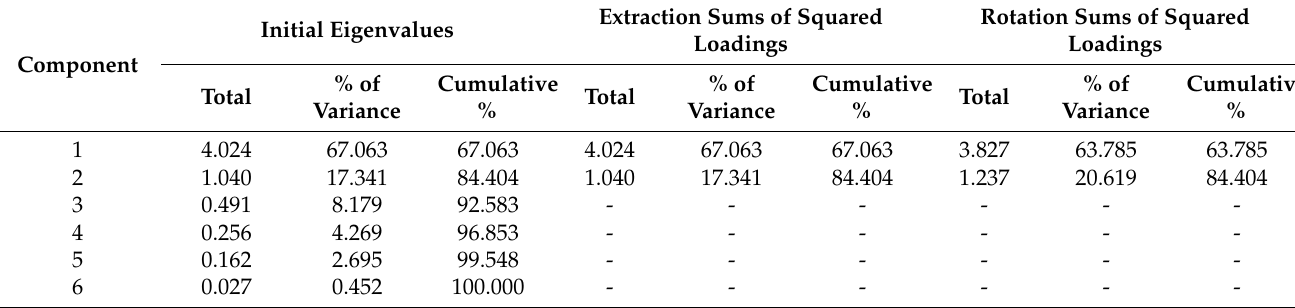
(Table 3). Combined interpretation of the PCA, MDS, and bivariant correlation data will be discussed below. Table 3. Principal Component Analysis of the heavy metals from the study area.